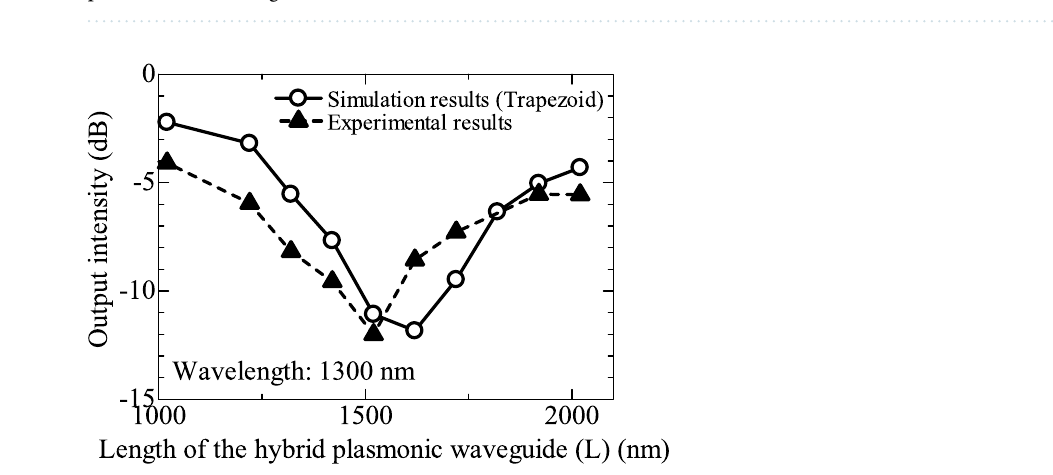
Figure 6. Output intensities as functions of L. The simulation results of the trapezoid structure same as the fabricated structure are shown by open circles (solid line), and the experimental evaluation results are shown by solid triangles (dashed